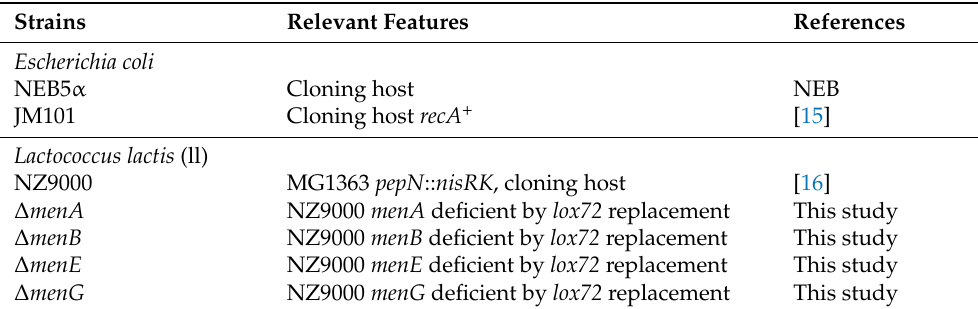
Table 1. Bacterial strains used in the biosynthesis gene knockout study. Strains Relevant